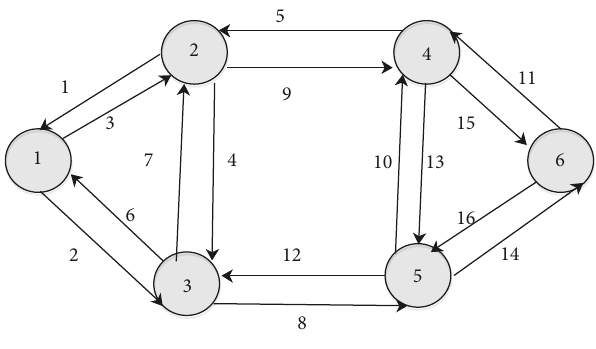
Figure 12: 16-link, 6-node network.